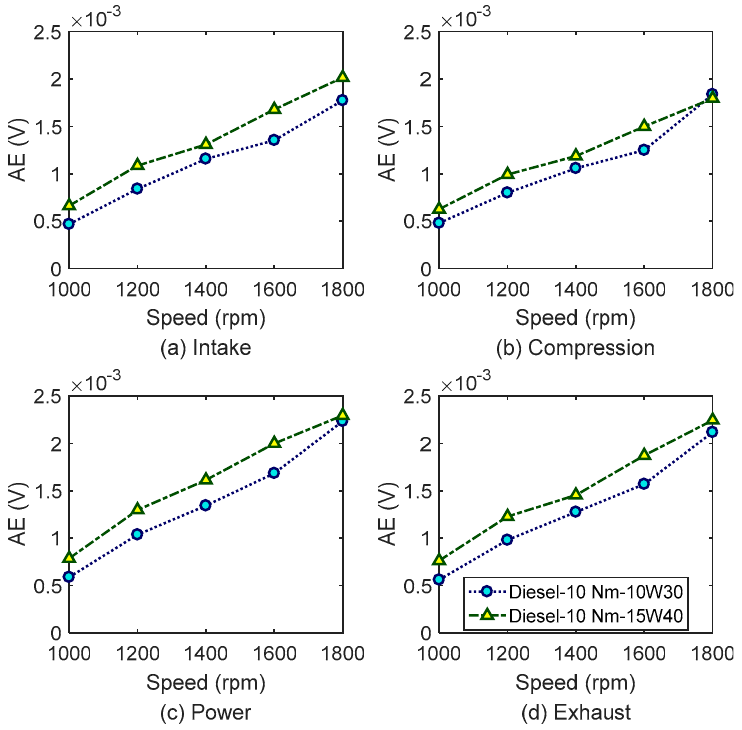
Figure 10. Fluid asperity shearing-acoustic emission (FAS–AE) indicators of two base line under low load: ( a ) Intake; ( b ) Compression; ( c ) Power; ( d ) Exhaust.